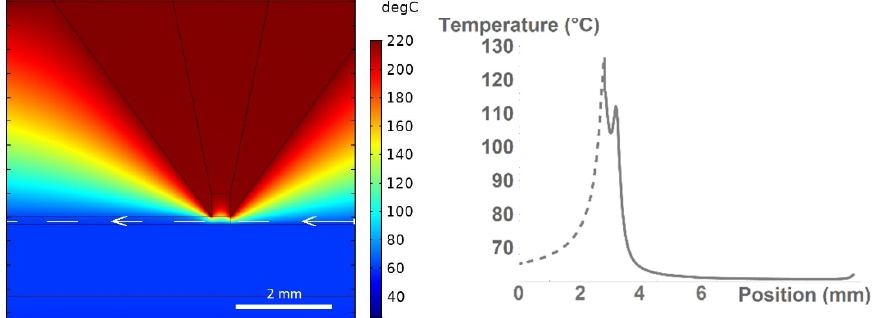
Figure 5. Detail of the printer nozzle/bed interface (left). Temperature distribution along the white line, where the white arrow denotes the direction of the x -axis (right). Printhead moves in the right direction.